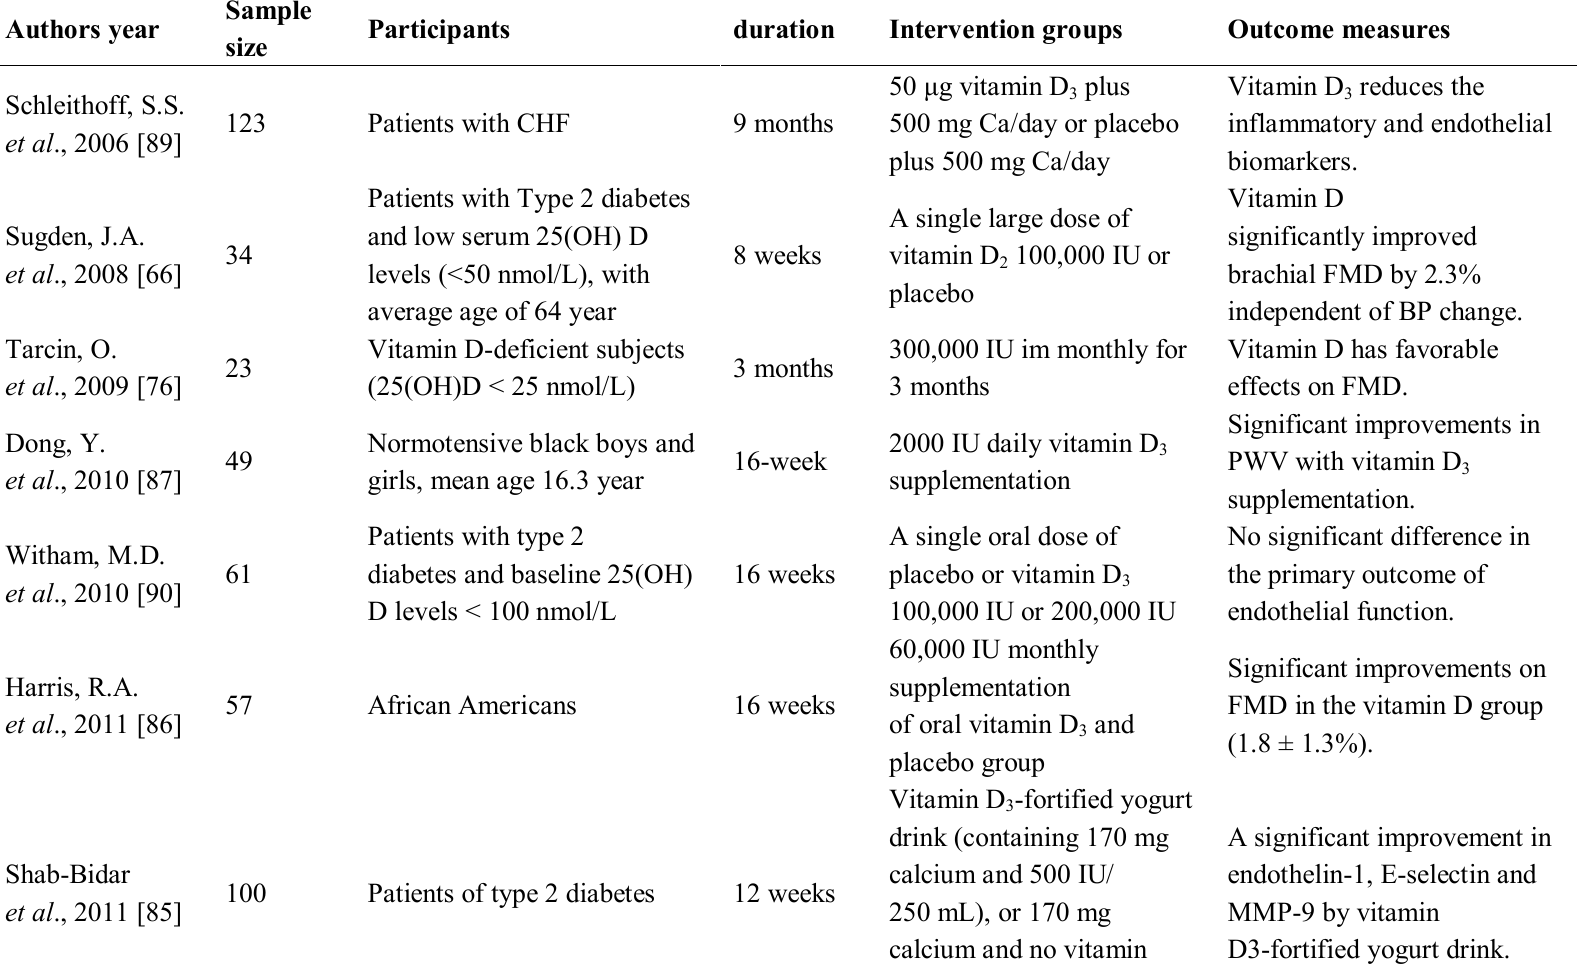
Table 1 . Randomized controlled trials on vitamin D supplementation and endothelial